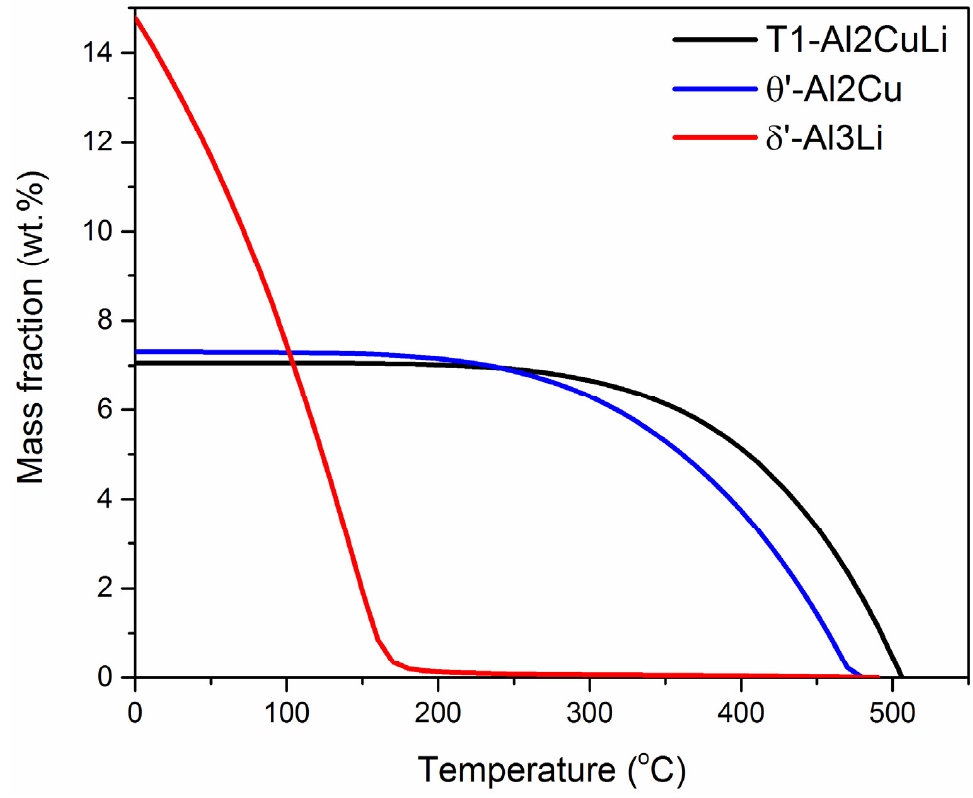
Figure 9. T1-Al2CuLi, δ ’-Al3Li and θ ’-Al2Cu calculated separately.